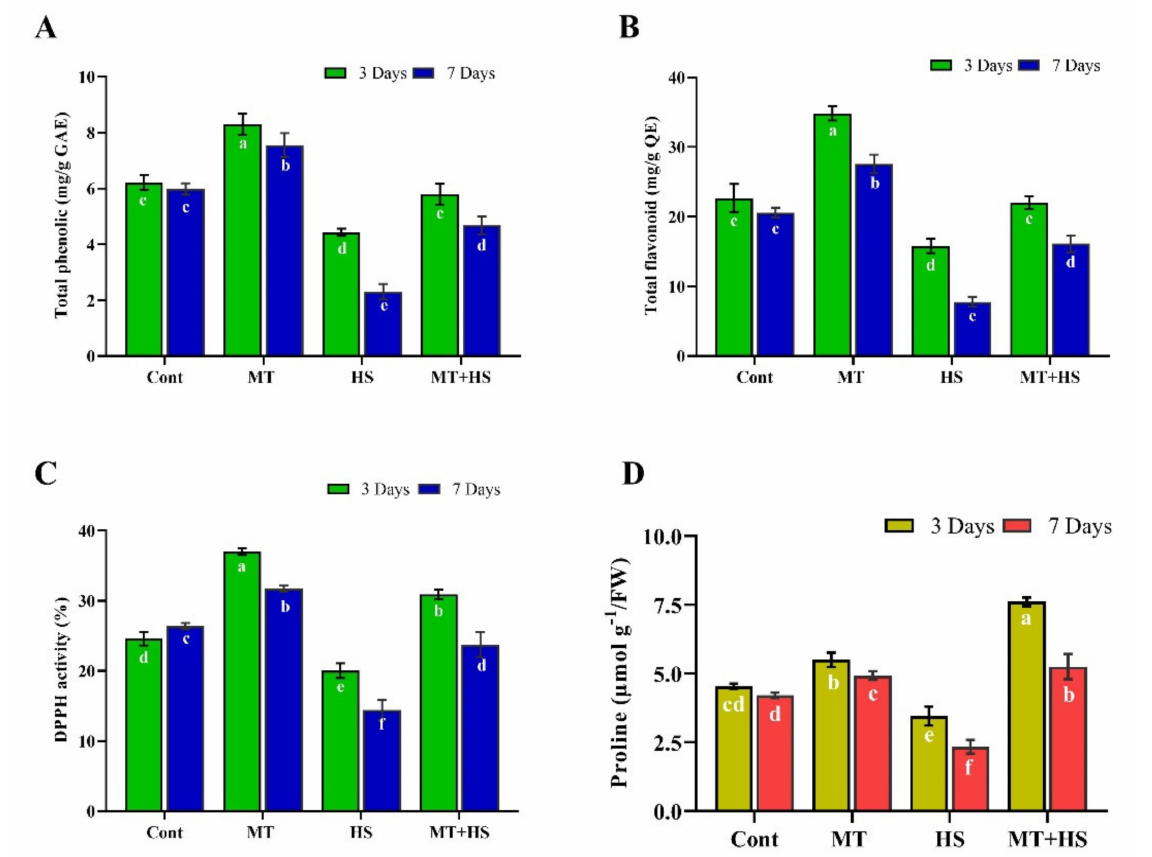
Figure 4. Effects of melatonin application with or without high temperature (42 ◦ C) on ( A ) total phenolic content, ( B ) total flavonoid content, ( C ) DPPH activity, and ( D ) proline accumulation in soybean seedling after 3 and 7 days. Each data point is the mean of three replicates. Error bars represent the standard error of the mean. Bars with different letters are significantly different from each other by Duncan’s multiple range test at p ≤